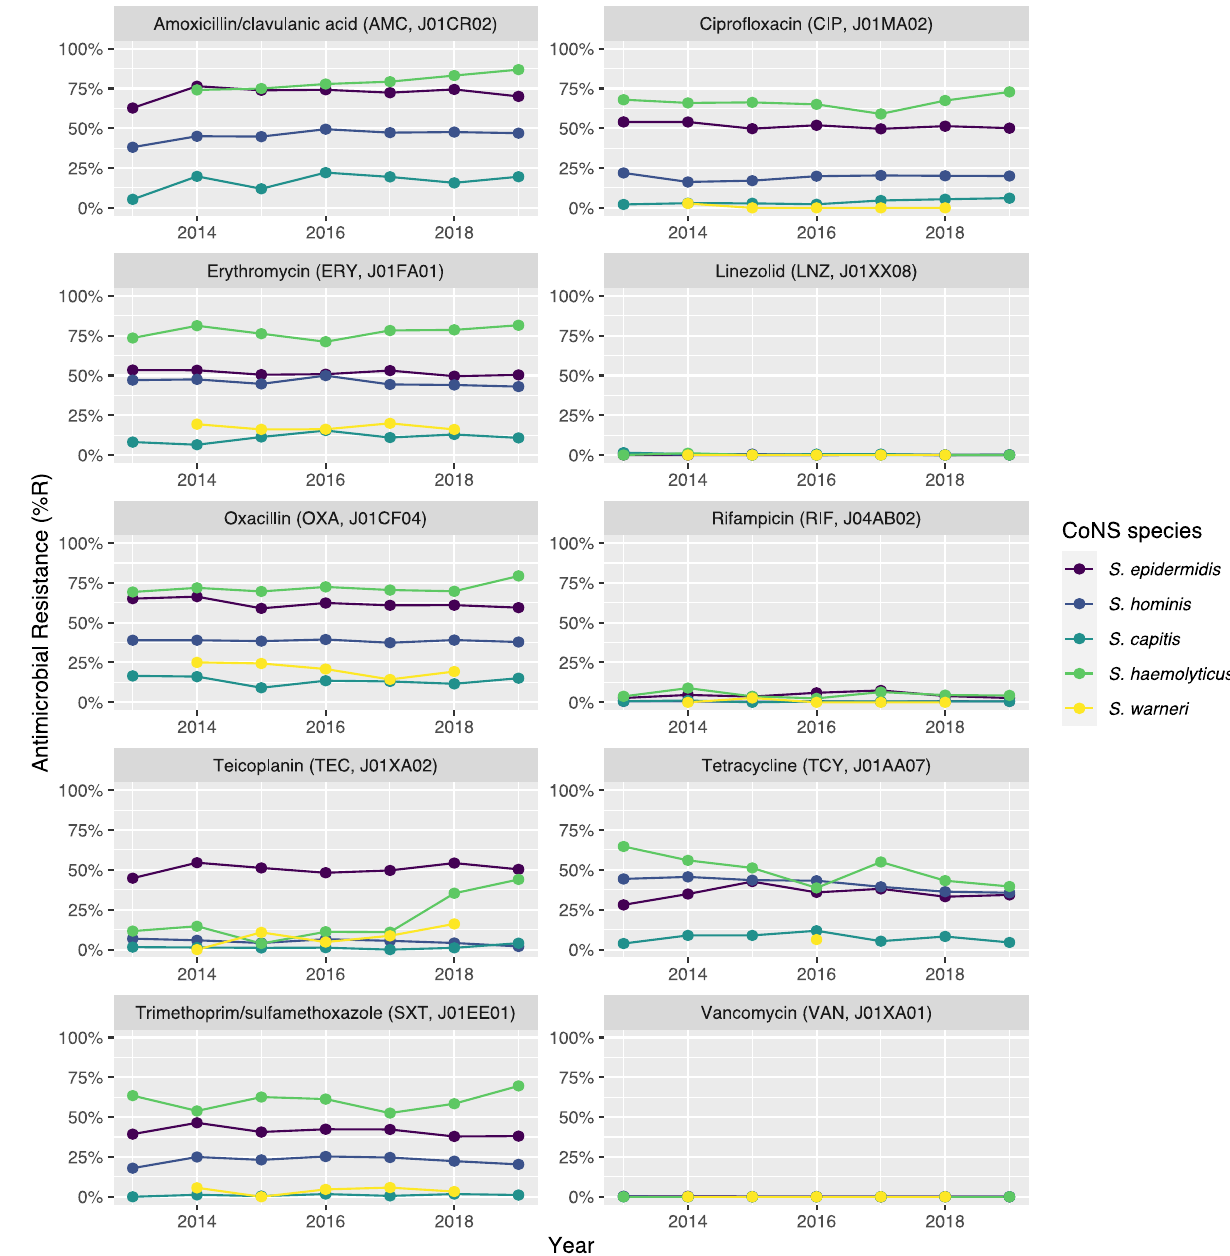
Figure 3. Antibiotic resistance of the five most occurrent CoNS (n = 14,560) over time between 2013 and 2019. Lines and points are missing where there were less than 30 isolates available for analysis.